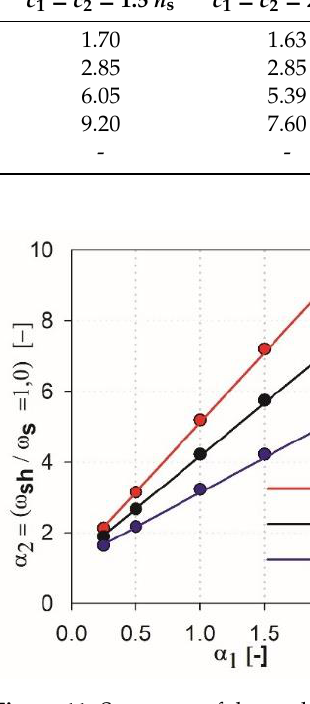
Figure 12. Summary of the analysis results—ACI 318. 4. Discussion It can be stated that the higher the shear cap (higher parameter 𝛼 1 ), the greater influence that independent variables of particular methods have on this analysis, and the greater the difference in the results that occur. In the case of the ACI318 code [1] for parameters 𝛼 1 = 0.25 and 𝛼 1 = 0.5 within 𝜔 𝑠ℎ /𝜔 𝑠 = 1 , relatively convergent results can be observed. The values of independent